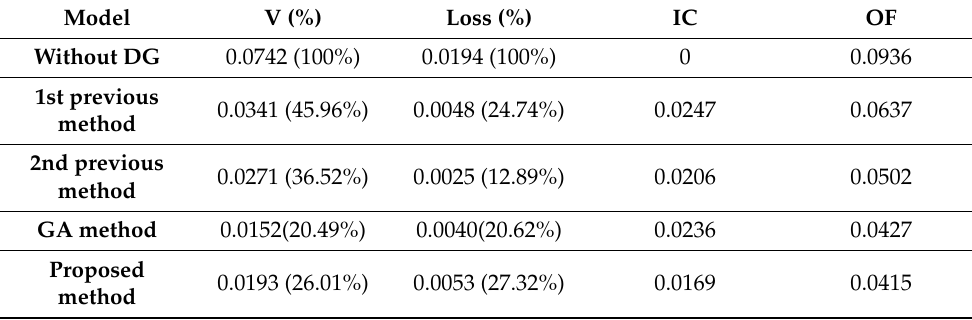
Figure 8. Line losses profile. Table 3. Detailed objective function values (the IEEE 30-bus test feeder).